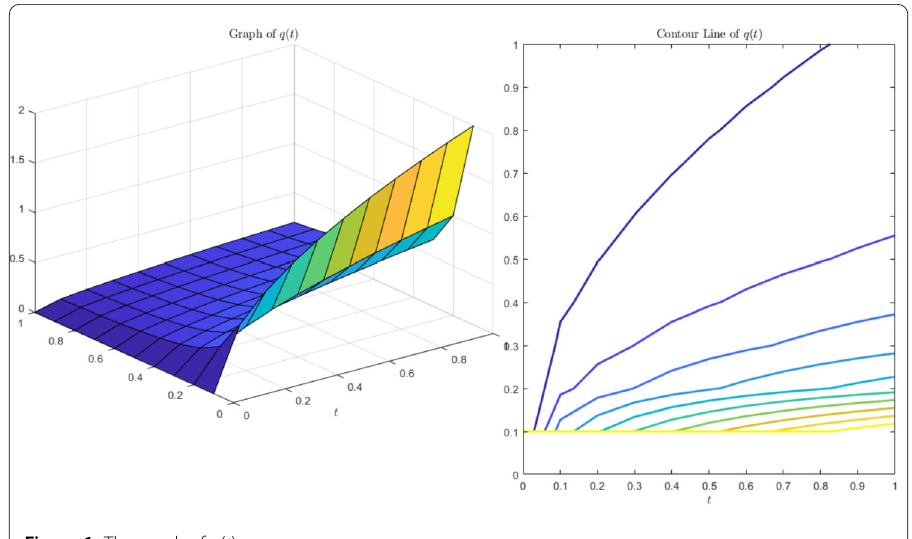
Figure 1 The graph of q ( t )